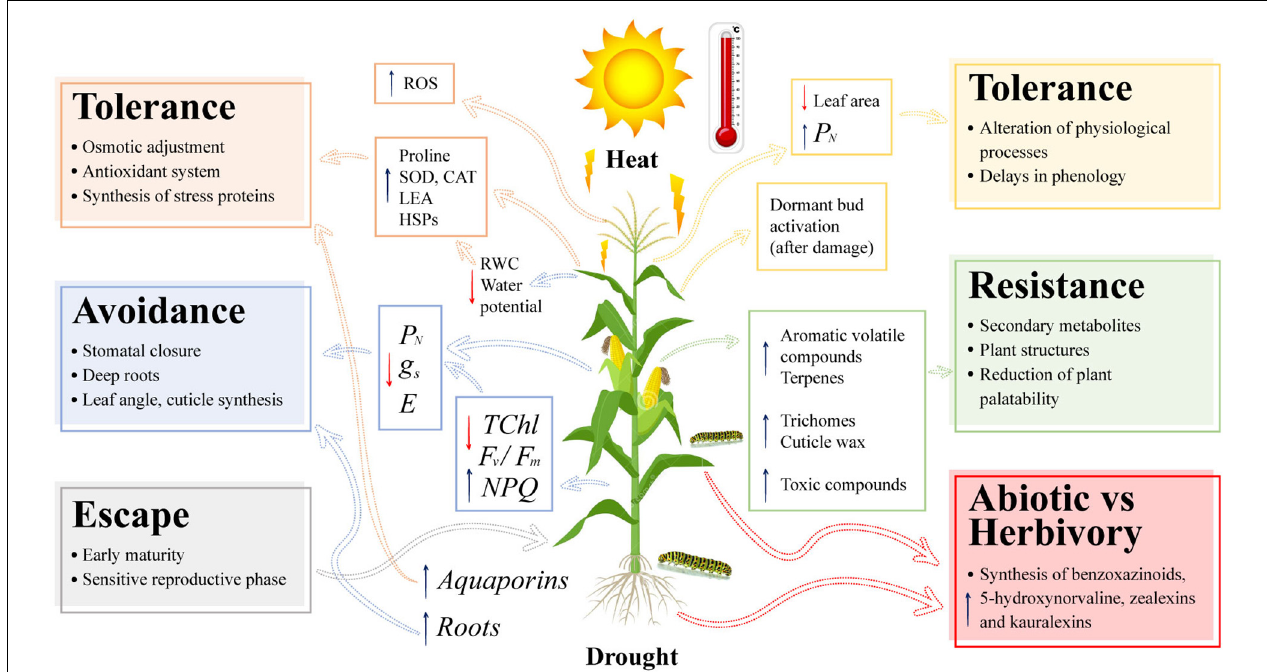
FIGURE 2 | Concept model of the morphological, physiological, biochemical, and molecular responses of maize plants ( Zea mays L.) to the impact of the combination of drought, heat stress, and arthropod herbivory. P N , net photosynthesis rate; g s , stomatal conductance; E , plant transpiration; TChl, total chlorophyll content; F v /F m , maximum quantum efficiency of PSII; NPQ, non-photochemical quenching; ROS, reactive oxygen species; SOD, superoxide dismutase; CAT, catalase; LEA, late embryogenesis abundant proteins; HSPs, heat shock proteins; and RWC, relative water content. Dotted arrows highlight responses and tolerance mechanisms of plants to single (drought, heat, or herbivory arthropod) or combined stresses. Blue or red arrows represent increase or decrease of plant responses at physiological, biochemical and molecular levels, respectively.